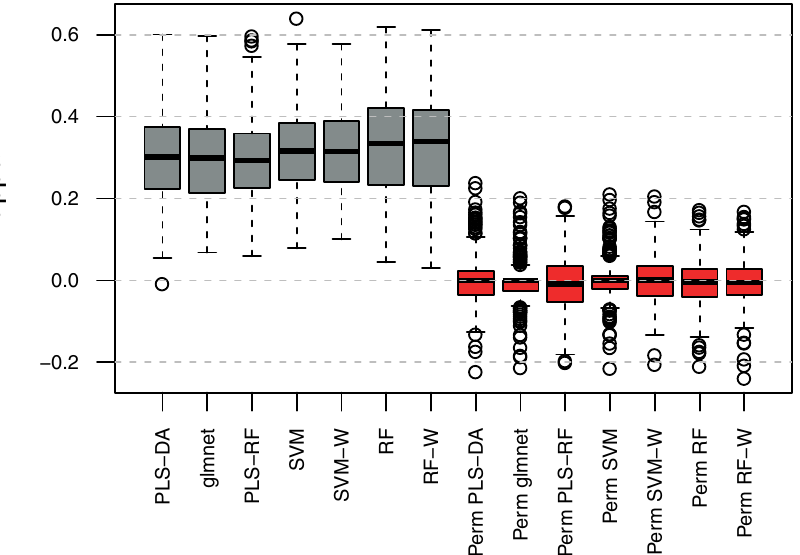
Fig 3. Comparison of classifiers’ performance. Each boxplot summarizes Kappa for classifying the metabolic inheritance patterns (mIPs) from 41 encoded analytes, each in five independent repetitions, with the following methods: linear discriminant analysis following a dimension-reducing partial least-squares transformation (PLS-DA, CV = 0.372), logistic regression with the elastic net (glmnet, CV = 0.370), random forests following a dimension- reducing partial least-squares transformation (PLS-RF, CV = 0.347), support vector machines (SVM, CV = 0.331), support vector machines with class-specific weights (SVM-W, CV = 0.321), random forests (RF, CV = 0.371) and random forests with class-specific weights (RF-W, CV = 0.374). Grey and red colors denote Kappa for the observed and permuted mIPs, respectively.